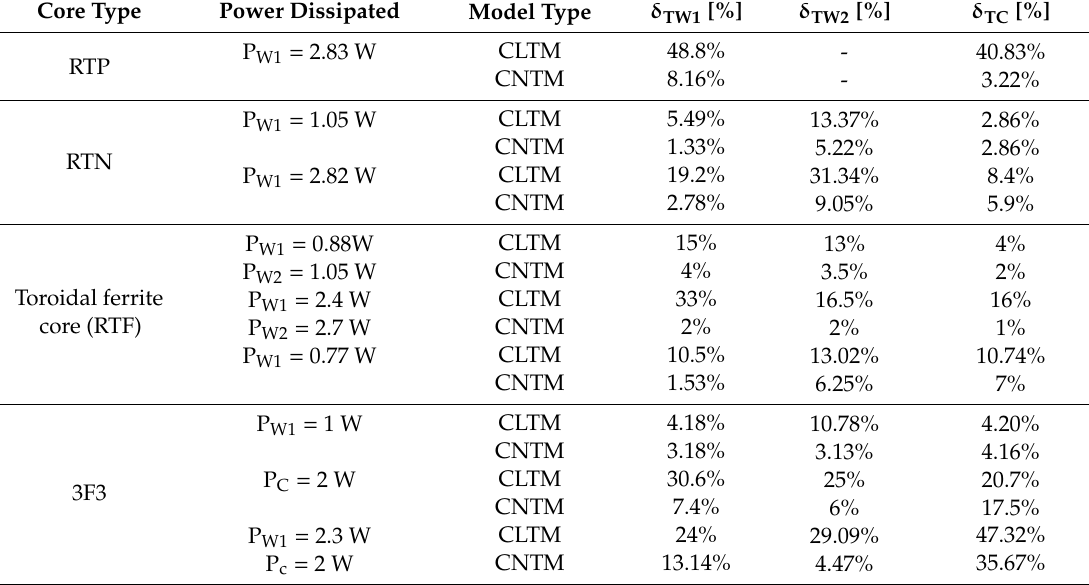
Table 4. Values of the maximum relative error of the temperatures of transformers components calculated with the CNTM and the compact linear thermal model